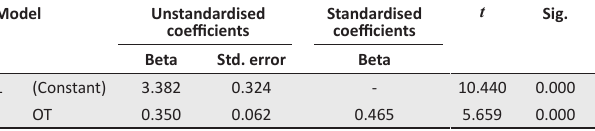
TABLE 5: Regression analysis (dependent variable: person–organisation fit; predictor: organisational trust). Model